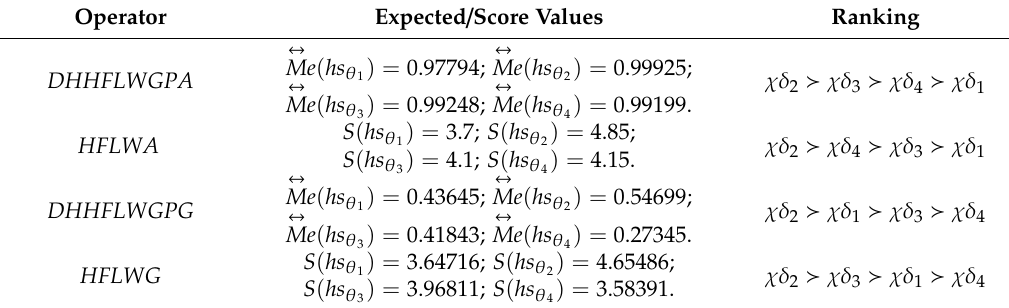
Table 6. Ranking results obtained by di ff erent methods.